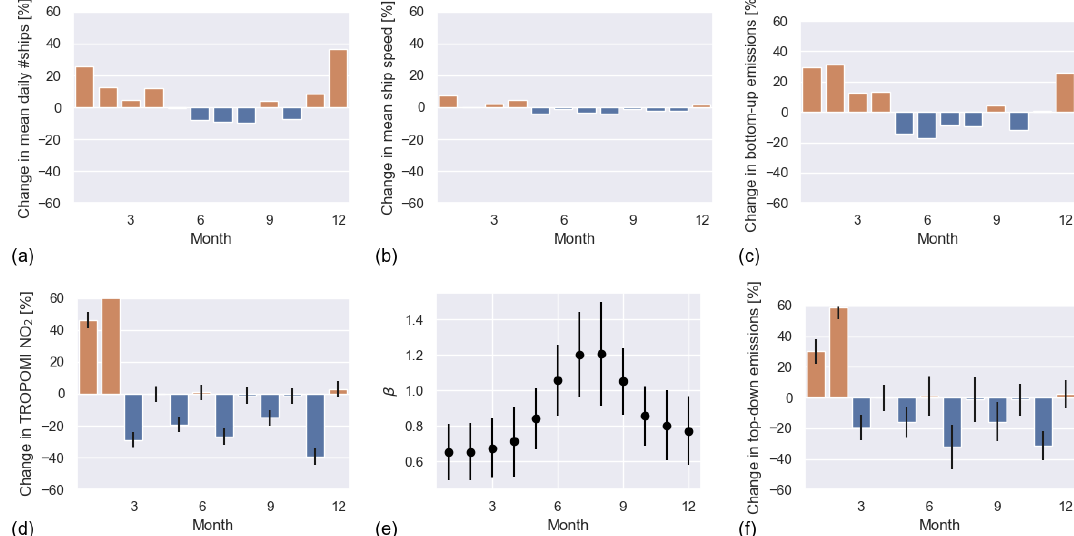
Figure F1. (a) Relative change in monthly mean of daily number of ships passing the Mediterranean shipping lane between 2019 and 2020. (b) Same but with average ship speed. (c) Relative change in emission proxy ( v 3 · L 2 ). (d) Relative change in TROPOMI shipping NO 2 ; the error bars indicate the sensitivity to changes in the area of study. (e) Monthly β values as discussed in Sect. 2.4. Error bars represent uncertainty originating from the temporal and spatial variability (see discussion in the text). (f) Relative change in top-down emissions from shipping. Error bars represent the propagated uncertainties in TROPOMI shipping NO 2 , β , and differences in meteorological conditions between 2019 and 2020 (see discussion in the